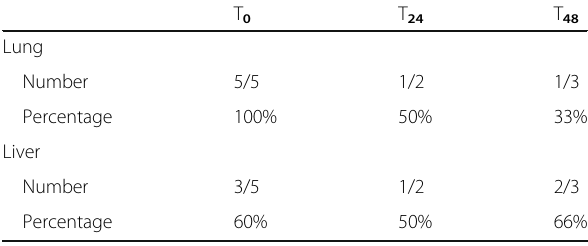
Table 3 Magnetic resonance imaging findings in the lung and liver of CS-labelled mesenchymal stromal cells